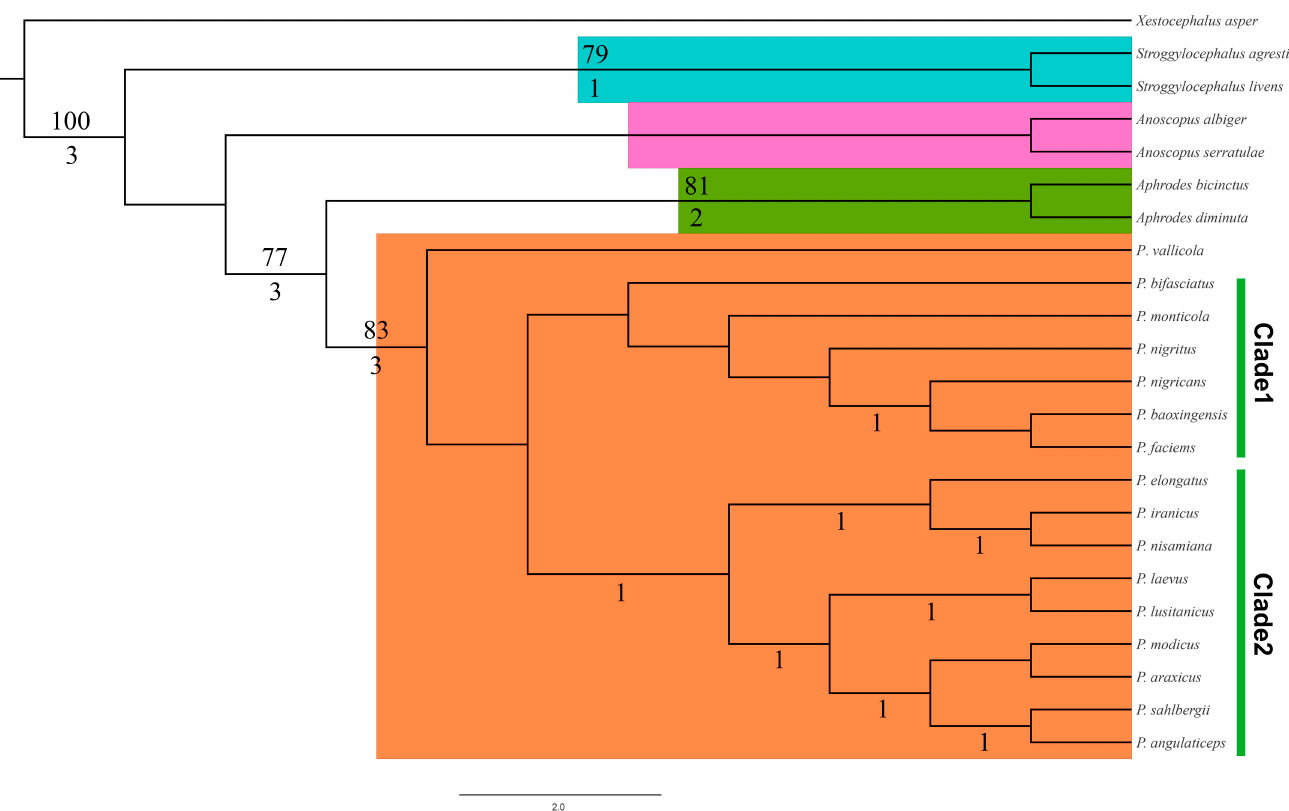
Figure 1. One of 4 most parsimonious cladograms of the tribe Aphrodini (Blue— Stroggylocephalus ; Pink— Anoscopus ; Green— Aphrodes ; Orange— Planaphrodes ) phylogenetic relationships indicated with bootstrap values (above branches) and Bremer’s decayindices (below branches).